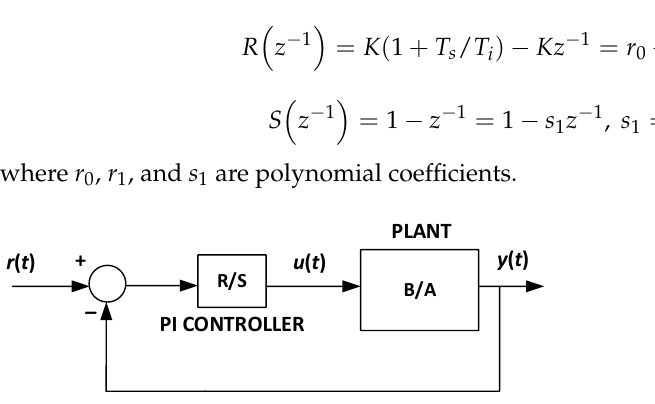
Figure 4. Closed-loop control system based on a PI controller. The closed-loop performance in terms of the settling time and overshoot is defined by a second-order polynomial corresponding to the discrete representation of a second- order system in the time domain according to Equation (11). Thus, one can define the control law using the pole allocation method. The parameters of polynomials R ( z − 1 ) and S ( z − 1 ) are calculated from the Diophantine equation corresponding to Equation (12) and its respective coefficients in Equations (13) and (14). It is then possible to obtain the coef- ficients of the digital PI controller from Equations (15) and (16).